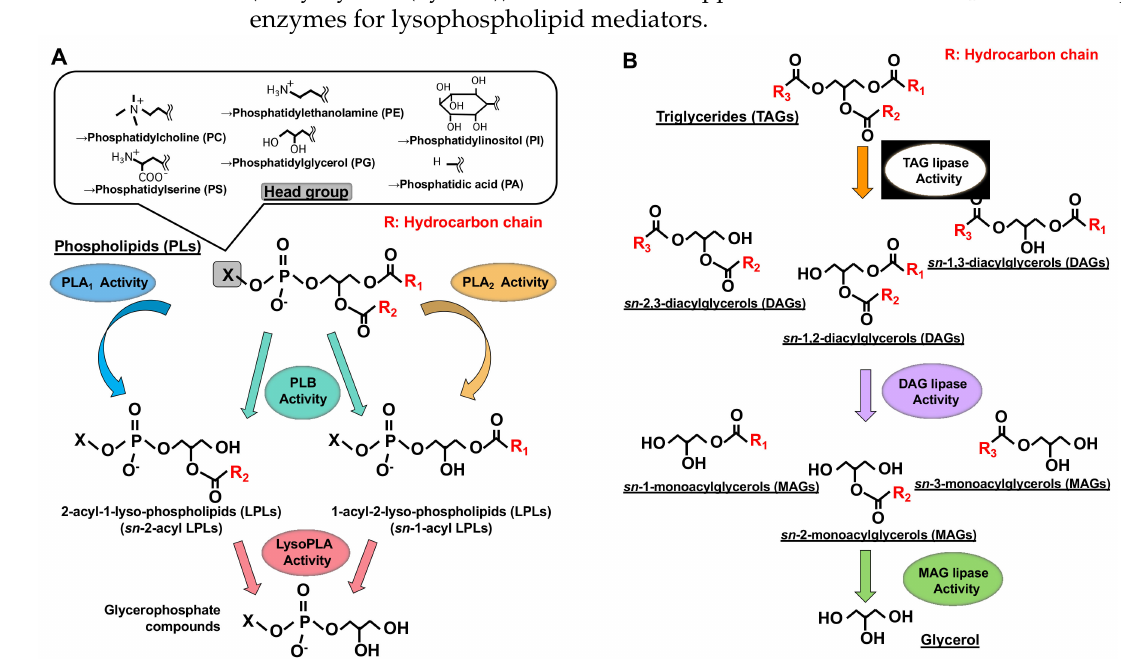
Figure 1. Structures of glycerolipids and their metabolic enzymes. ( A ) Glycerophospholipids (GPL) and phospholipases. GPLs are composed of a polar head group (six major classes), a glycerol backbone and fatty acid moieties (esterified at the sn -1 and sn -2 positions). Phospholipase A 1 (PLA 1 ) hydrolyzes a fatty acid at the sn -1 position, generating sn -2-acyl-1-lyso-phospholipids ( sn -2-acyl LPLs), while phospholipase A 2 (PLA 2 ) hydrolyzes a fatty acid at the sn -2 position generating sn -1- acyl-2-lyso-phospholipids ( sn -1-acyl LPLs). Phospholipase B (PLB) hydrolyzes a fatty acid at both sn -1 and sn -2 positions. LysoPLA hydrolyzes a fatty acid of sn -2-acyl LPLs and sn -1-acyl LPLs, generating glycerophosphate compounds. ( B ) Triacylglycerol (TAG) has three fatty acids at the sn -1, sn -2 and sn -3 positions of glycerol backbone, diacylglycerol (DAG) has two fatty acids and monoacylglycerol (MAG) has one fatty acid. TAG lipase hydrolyzes a fatty acid of TAG, generating sn -1, 2, sn -2, 3 or sn -1, 3-diacylglycerols (DAGs). DAG lipase hydrolyzes a fatty acid of DAG and MAG lipase hydrolyzes a fatty acid of MAG.